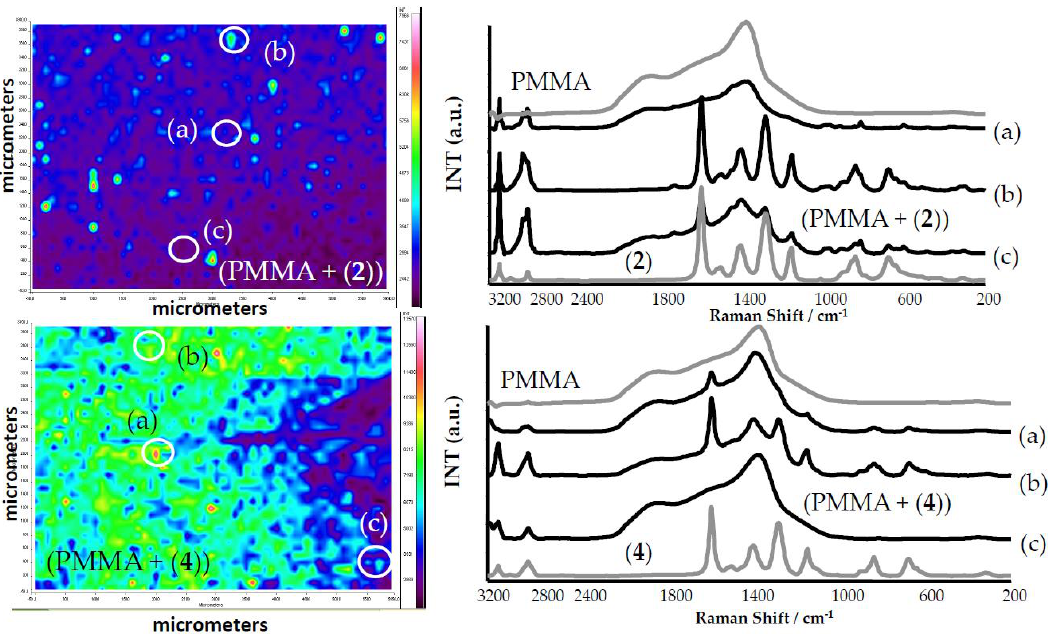
Figure 5. Raman microscopy maps, registered for PMMA + TOC composites (TOCs ( 2 ) and ( 4 )). Figure 5. Raman m i croscopy maps, registered for PMMA + TOC composites (TOCs ( 2 ) and ( 4 )). The The Raman spectra, in selected points (a)–(c) on the surface of PMMA + TOCs, are presented alongside. Raman spectra, in selected points (a) – (c) on the surface of PMMA + TOCs, are presented alongside.